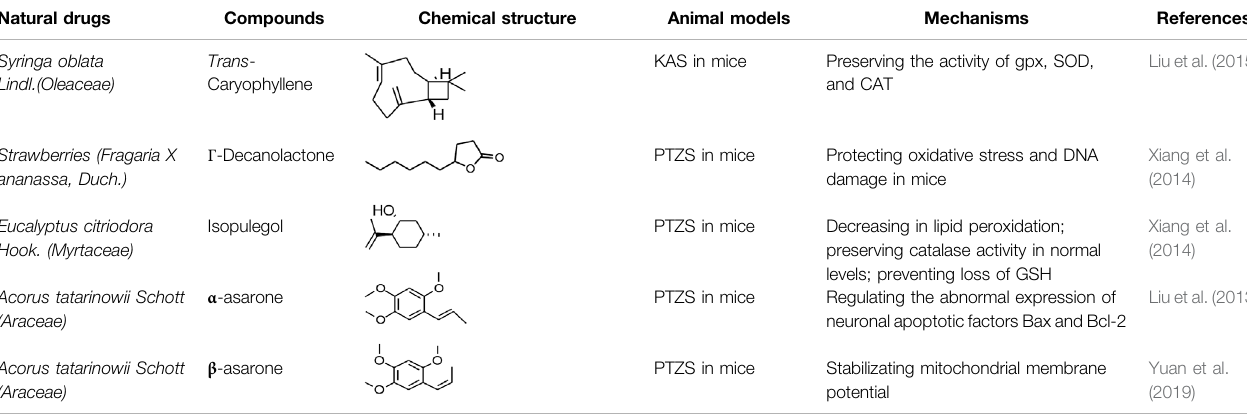
Frontiers in Pharmacology |